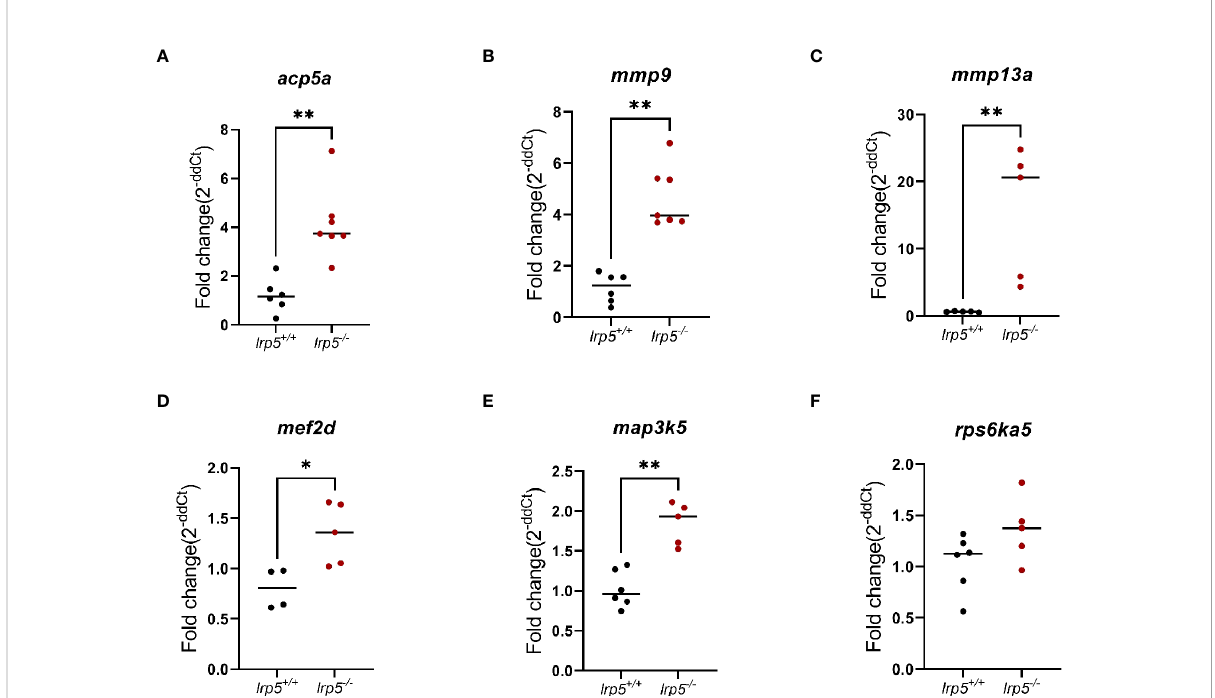
FIGURE 5 RT-qPCR validation of RNA-Seq data. Genes relevant to osteoclasts activity (A-C) and osteoclasts differentiation (D-F) . (n=6-7, Mann-Whitney test, dots represent each individual value distributed around mean (line): in black lrp5 +/+ control, dark red lrp5 -/ - ). Mann-Whitney test p-values: *p ≤ 0.05, **p ≤